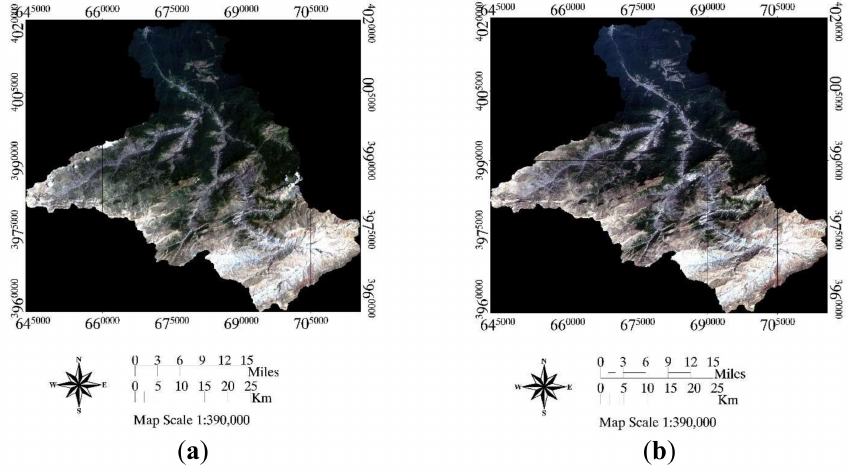
Figure 2. Satellite images (Path/Row: 163/35) ( a ) 9 June 1991 and ( b ) 10 June